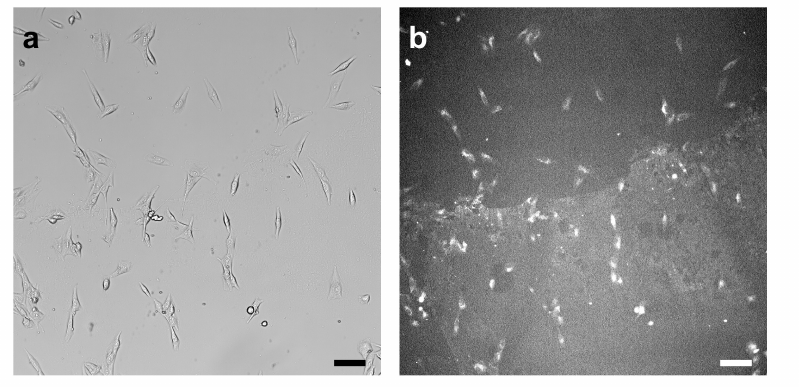
Figure 5. MG-63 cells 24 h after seeding onto a BSA µ CP glass surface. The scalebars in the bottom right corner indicate 100 µ m ( a ) Brightfield image of a representative spot at the transition from glass- to BSA-surface. A homogeneous cell distribution is present. ( b ) Corresponding auto-fluorescence image. The bright area (bottom half) shows the presence of a BSA-layer. A total of 36 cells are adhered on glass while 43 reside on the BSA-layer. Considering the area of the molecule layer vs. glass (0.74mm 2 and 0.65mm 2 , respectively) the cell density is similar. This shows that there is no glass preference in terms of cell adhesion when unstructured BSA-layers are